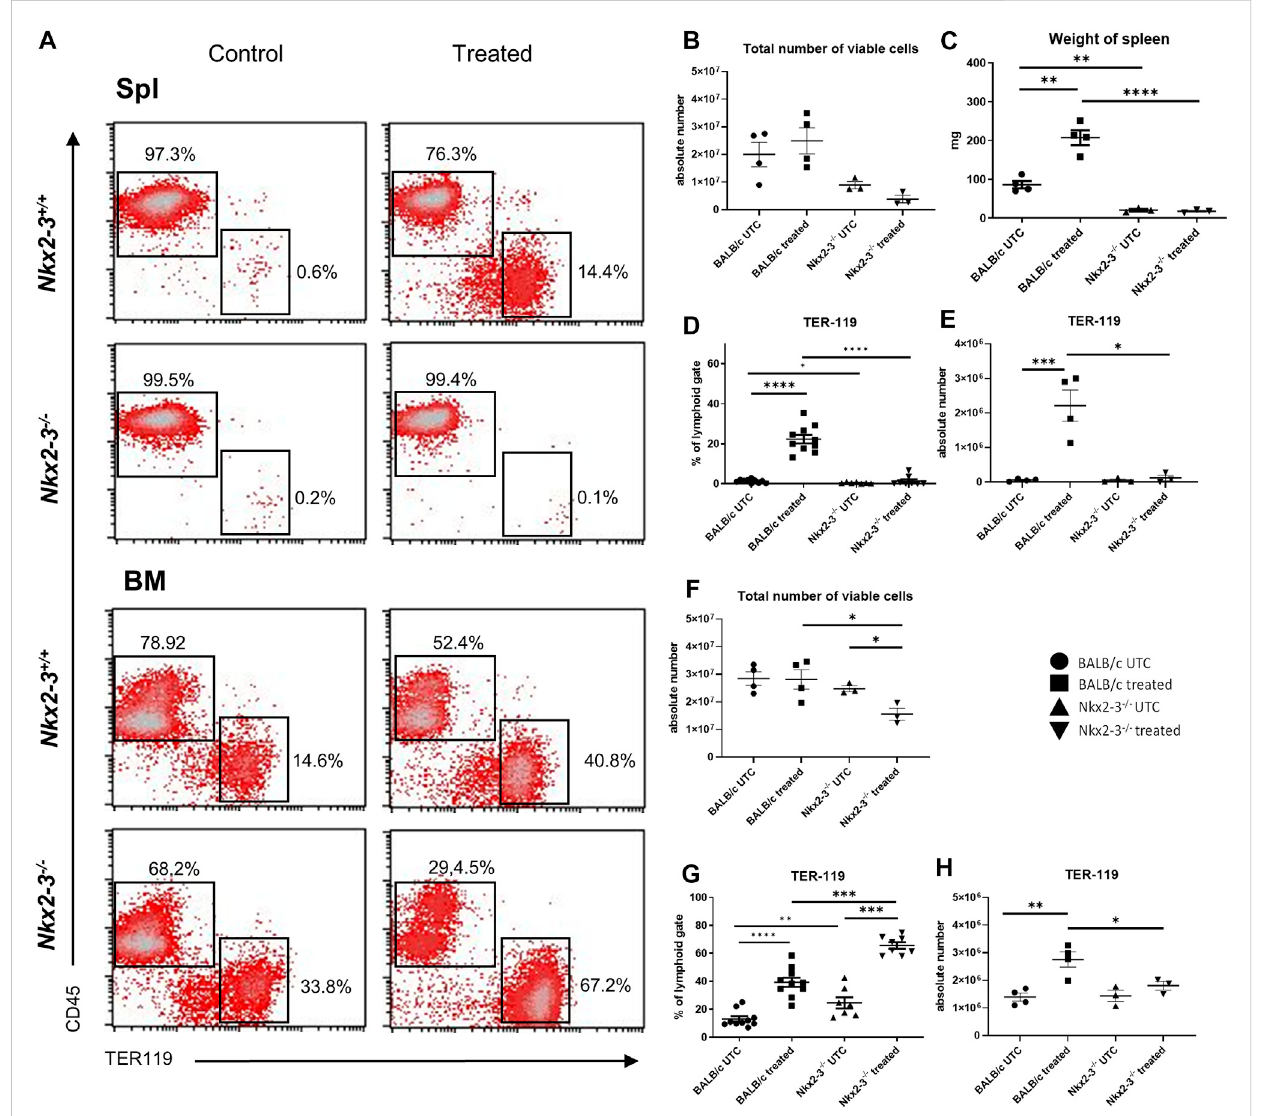
FIGURE 5 Acute blood loss in Nkx2-3 − / − mice induces imbalanced erythropoietic responses in the bonee marrow and spleen. Representative fl ow cytometric plots demonstrate results of the distribution of bone marrow and spleen lymphoid and erythroid cells in BALB/c and Nkx2-3 − / − UTC and treated mice, numbersindicaterelativefrequencyintherectangles (A) .Total numberoflymphoidgatedspleencellsinBALB/c(UTCn=4,treatedn=4)andNkx2-3 − / − (UTCn=3,treatedn=3)mice (B) . WetweightofspleeninBALB/c(UTCn=4, treatedn=4)and Nkx2-3 − / − (UTC n=3, treatedn=3) mice (C) .Ratio of splenic erythroid cells in BALB/c (UTC n = 10, treated n = 10) and Nkx2-3 − / − (UTC n = 7, treated n = 8) mice (D) . Absolute number of splenic erythroid cells in BALB/c (UTC n = 4, treated n = 4) and Nkx2-3 − / − (UTC n = 3, treated n = 3) mice (E) . Total number of lymphoid gated viable bone marrow cells in BALB/c(UTCn=4,treatedn=4)andNkx2-3 − / − (UTCn=3,treatedn=3)mice (F) .RatioofbonemarrowerythroidcellsinBALB/c(UTCn=10,treatedn= 10)andNkx2-3 − / − (UTCn=7,treatedn=8)mice (G) .AbsolutenumberofbonemarrowerythroidcellsinBALB/c(UTCn=4,treatedn=4)andNkx2-3 − / − (UTC n = 3, treated n = 3) mice (H) . * p < 0.05, ** p < 0.01, *** p < 0.001, **** p < 0.0001 by unpaired t -test and Mann Whitney U